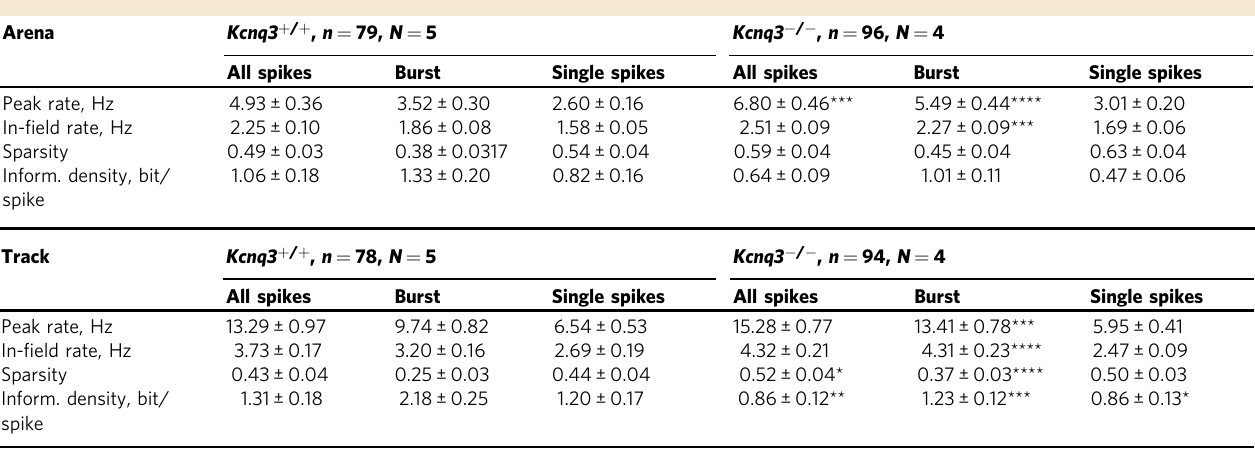
(Fig. 4j, Supplementary Fig. 6e). Spike waveforms of photo- responsive cells did not change during optogenetic stimulation (Fig. 4j). During movement, a fraction of MS cells displayed a clear modulation according to the phase of locally recorded LFP theta oscillation (Fig. 4k). The theta-rhythmic activity was observed in ~50% of both putative ChAT - and ChAT + cells (Fig. 4l).